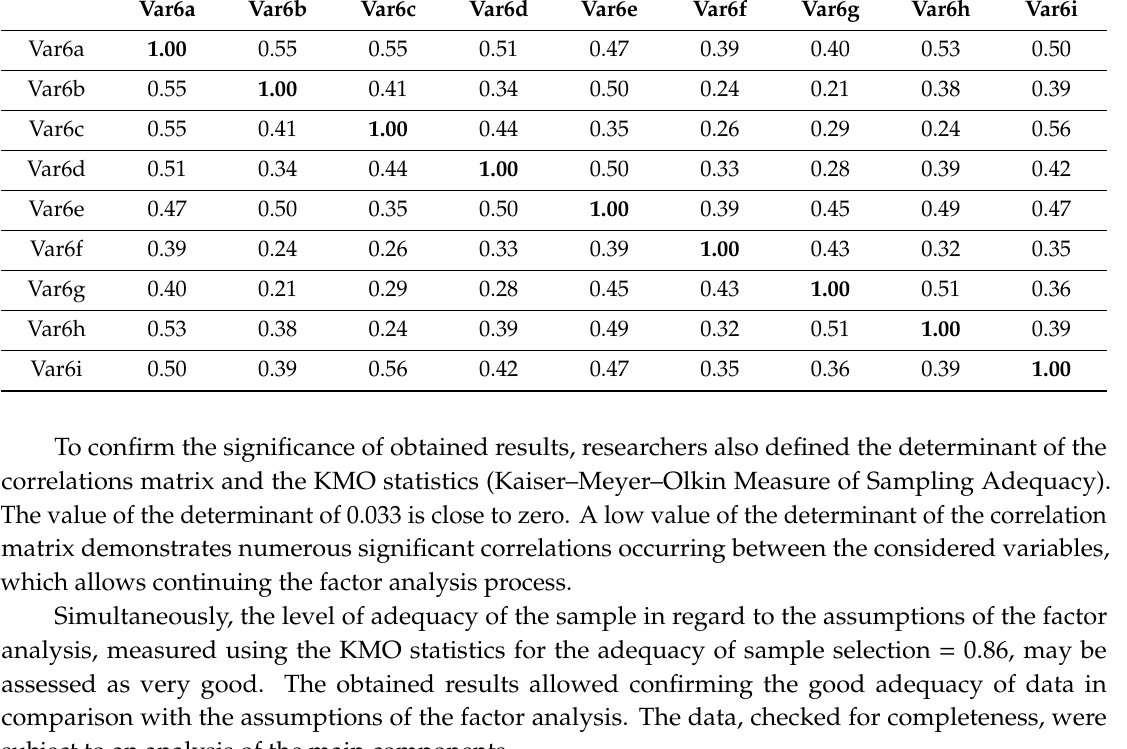
Table 4. Coe ffi cients of the correlation for the variable “Energy management benefits” (Var6).